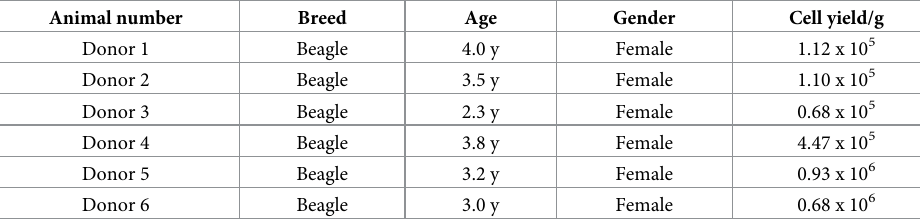
Table 2. Cell yields from processed canine adipose